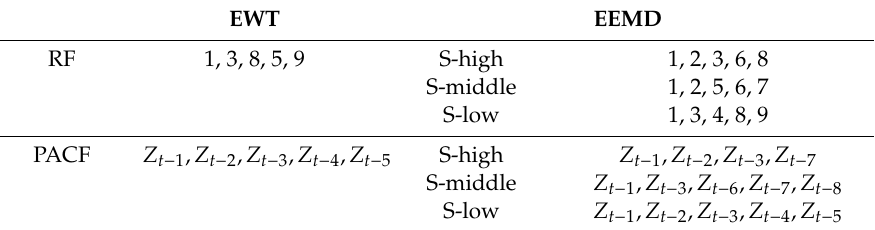
Figure 19. The PACF results of signal reconstruction by EEMD of “front flat line 95.” Table 5. The input of ice thickness prediction of “front flat line